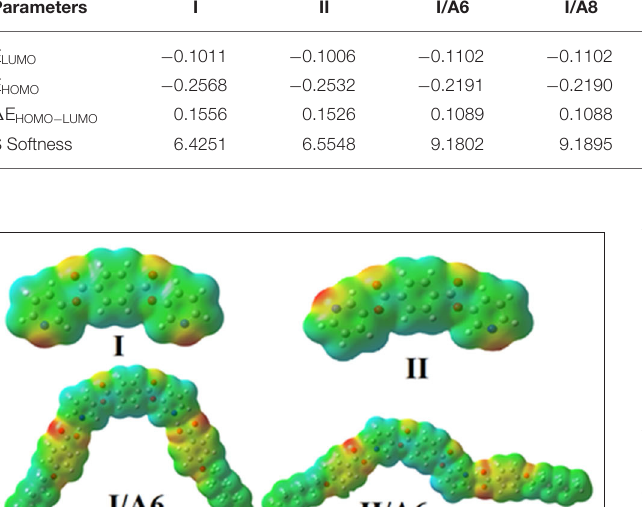
TABLE 4 | FMO Energies a.u., polarizability, α , and dipole moment µ (Debye) of conformers of the di-nicotinate base and their SMHBCs, I/An and II/A6 . Parameters